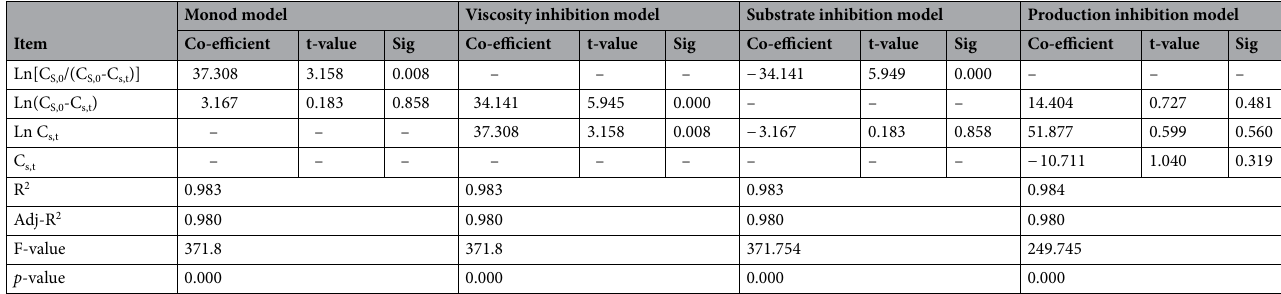
Table 3. The results of kinetic equation fitting of viscous fermentation broth and the results of